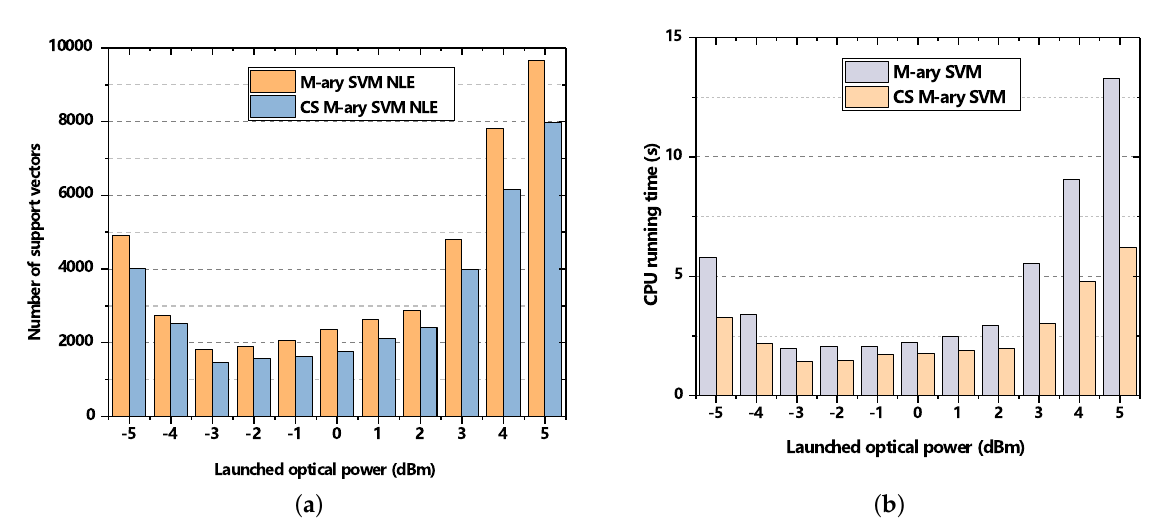
Figure 11. ( a ) The number of support vectors ( b ) CPU running